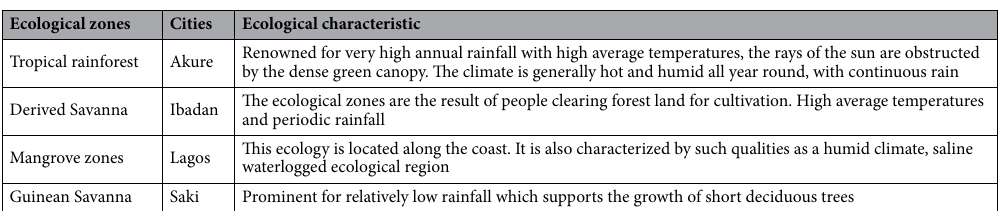
Table 1. Ecological characteristics of the cities examined in the